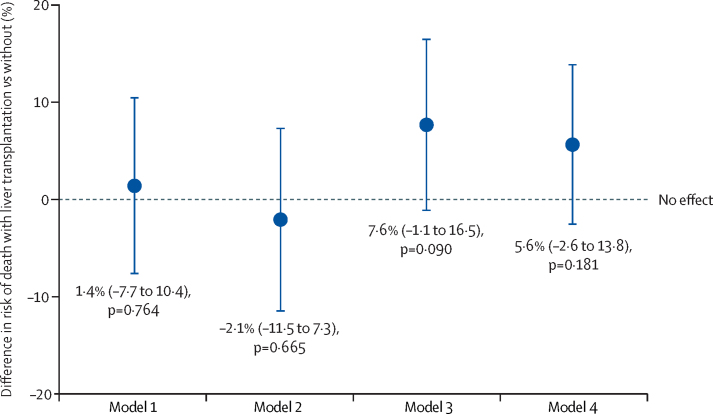
Propensity score-matched models for the association between liver transplantation and death in patients with severe acute respiratory syndrome coronavirus 2 infectionThe plot shows four separate propensity-score matched models with liver transplantation as the treatment variable and death as the outcome variable. Risk difference (95% CI) is presented for each model. For model 1, variables included in the calculation of propensity score were age, sex, obesity, white ethnicity, hypertension, diabetes, and serum creatinine. Subsequent models also included interactions with age (model 2), interactions with serum creatinine and age (model 3), and interactions with age but with serum creatinine concentration omitted (model 4). Seven (5%) of 151 transplant patients lacked baseline data for serum creatinine and were not included in models including serum creatinine. Further details are provided in the appendix (pp 9, 11).